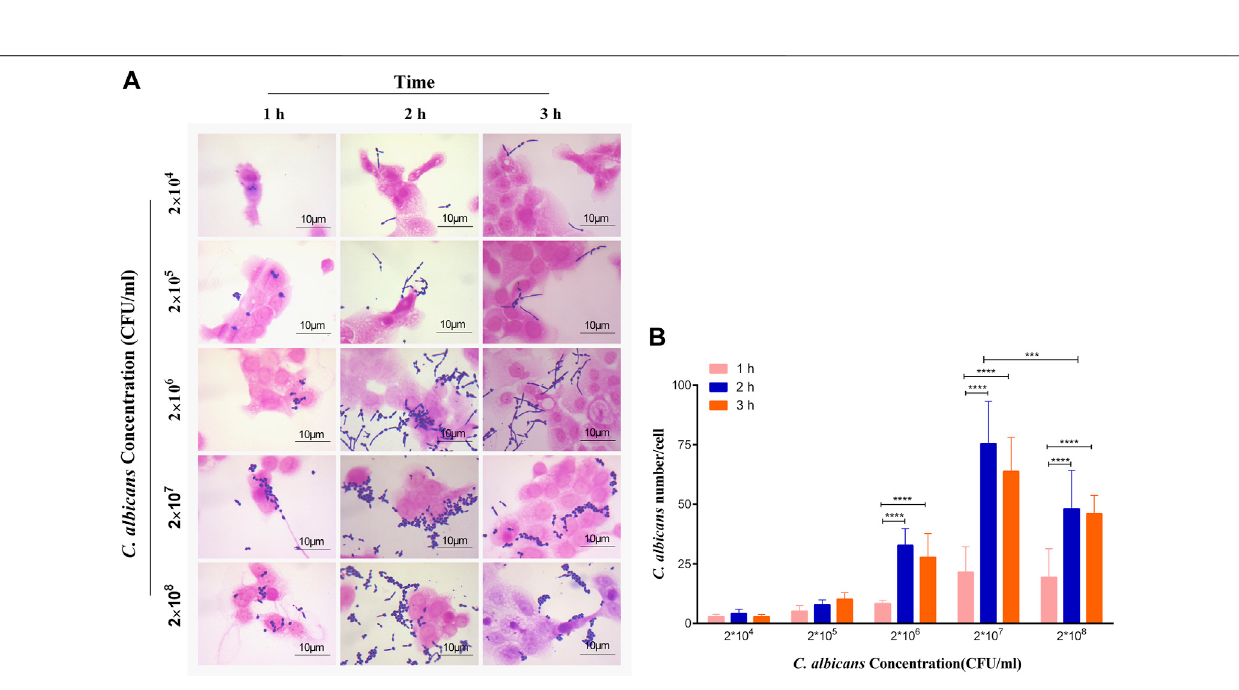
FIGURE 3 | (A) Observation and (B) quanti fi cation of different concentrations of C. albicans on its adherence to A431 cells at 1, 2 and 3 h, respectively. **** p < 0.0001. vs. 1 h group. Scale bar, 10 μ